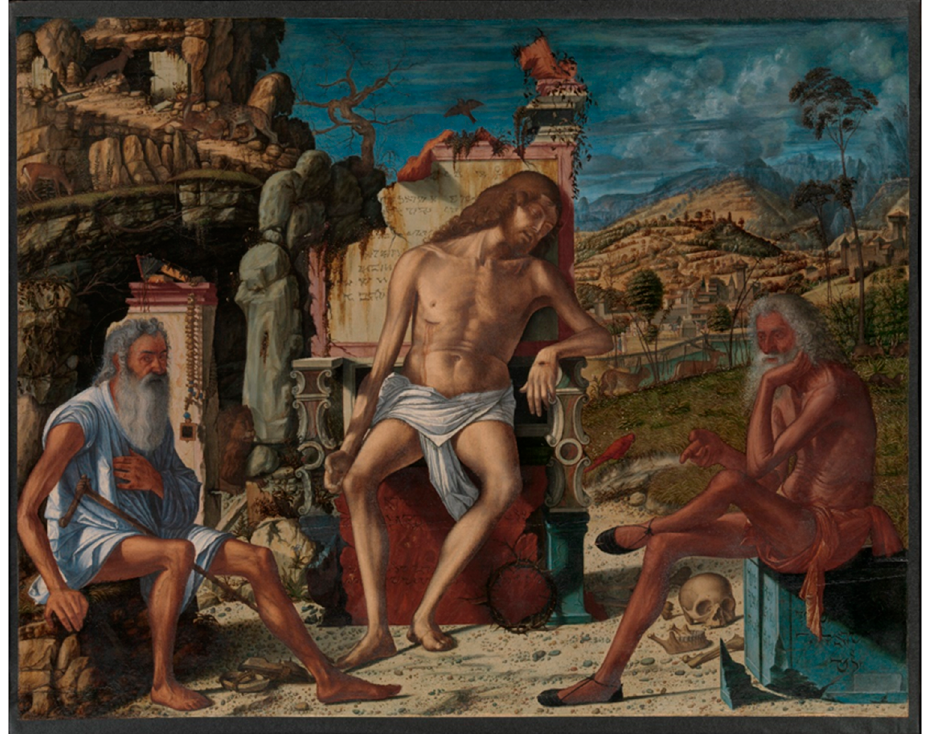
Figure 1. Vittore Carpaccio (Italian, ca. 1464–1525 / 6), Meditation on the Passion , ca. 1490–1510, oil and tempera on wood, 27 3 / 4 × 34 1 / 8 in. (70.5 × 86.7 cm), New York, The Metropolitan Museum of Art.